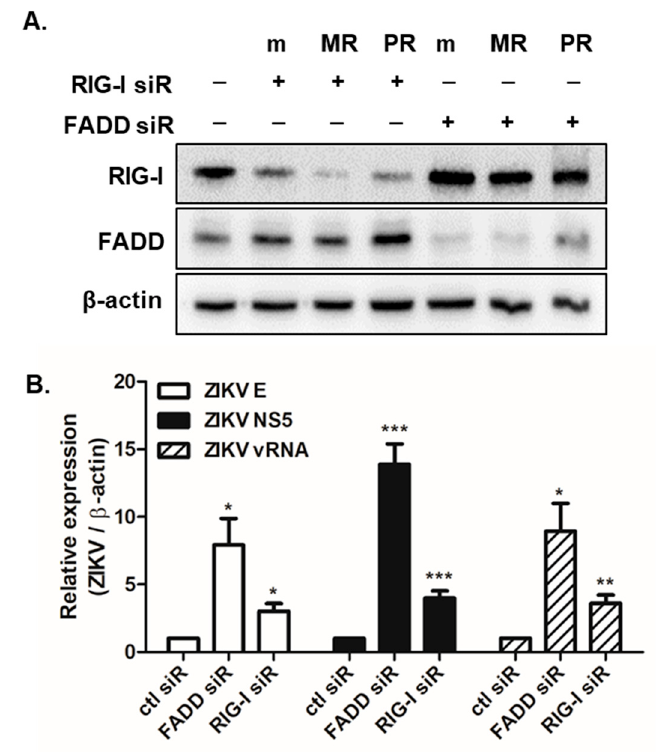
Figure 5. The knockdown of TRAIL adaptor FADD results in increased ZIKV replication. ( A ) A549 cells were transfected with either control, RIG-I, or FADD siRNA. After 24 h, cells were mock (m)- or MR766 (MR)- or PRVABC59 (PR)-infected for 24 h. The knockdown efficiency of RIG-I or FADD siRNA was determined by measuring the expression levels of RIG-I or FADD protein by western blot. Data representative of three independent experiments are shown. ( B ) mRNA levels of ZIKV E, NS5, and vRNA were measured using qRT-PCR. Gene expression was normalized to β -actin and the expression level of control siRNA-transfected cells infected with ZIKV was arbitrarily set to 1. * p < 0.05; ** p < 0.01; *** p < 0.001 versus control siRNA-transfected ZIKV-infected cells.